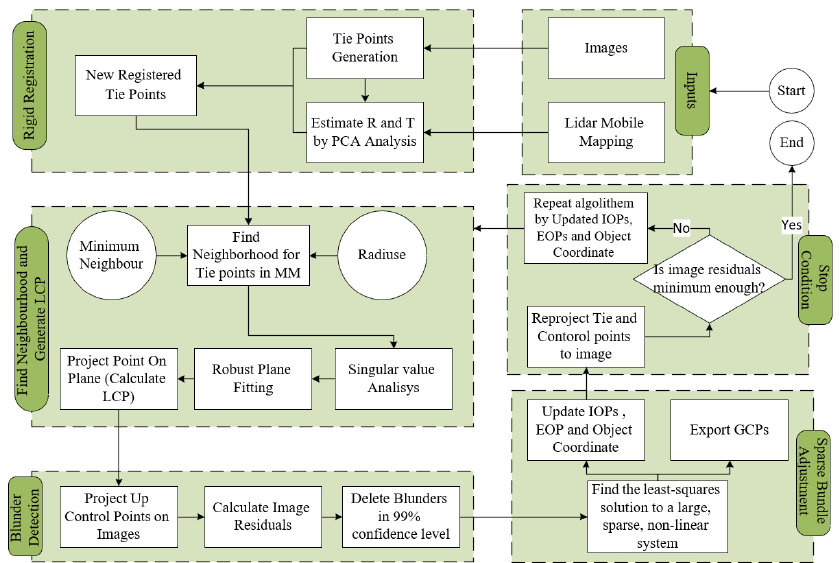
Figure 1. Flowchart of our proposed approach.